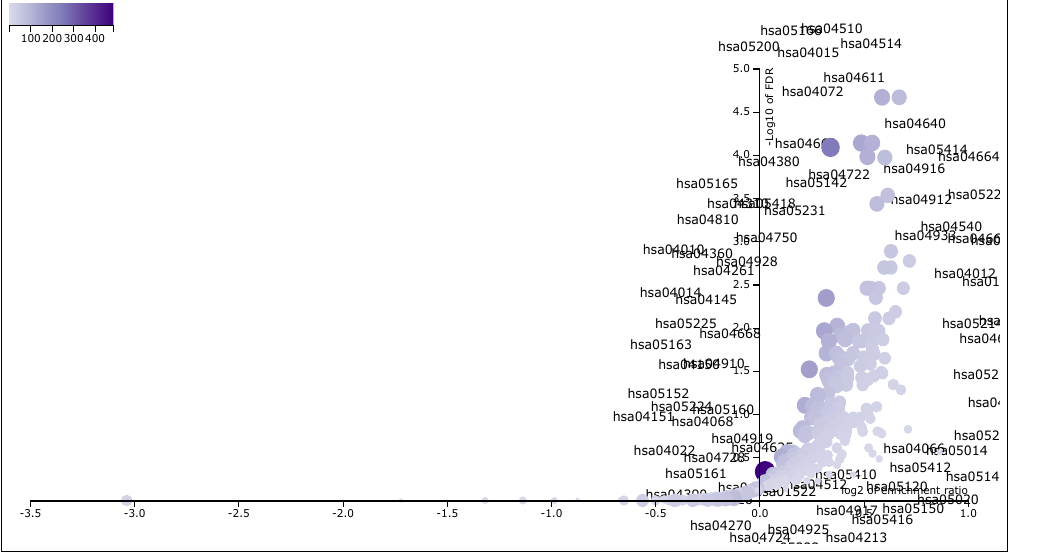
Figure 4. The volcano plot of normalized enrichment score of the FDR significant KEGG pathways from GSEA analysis of